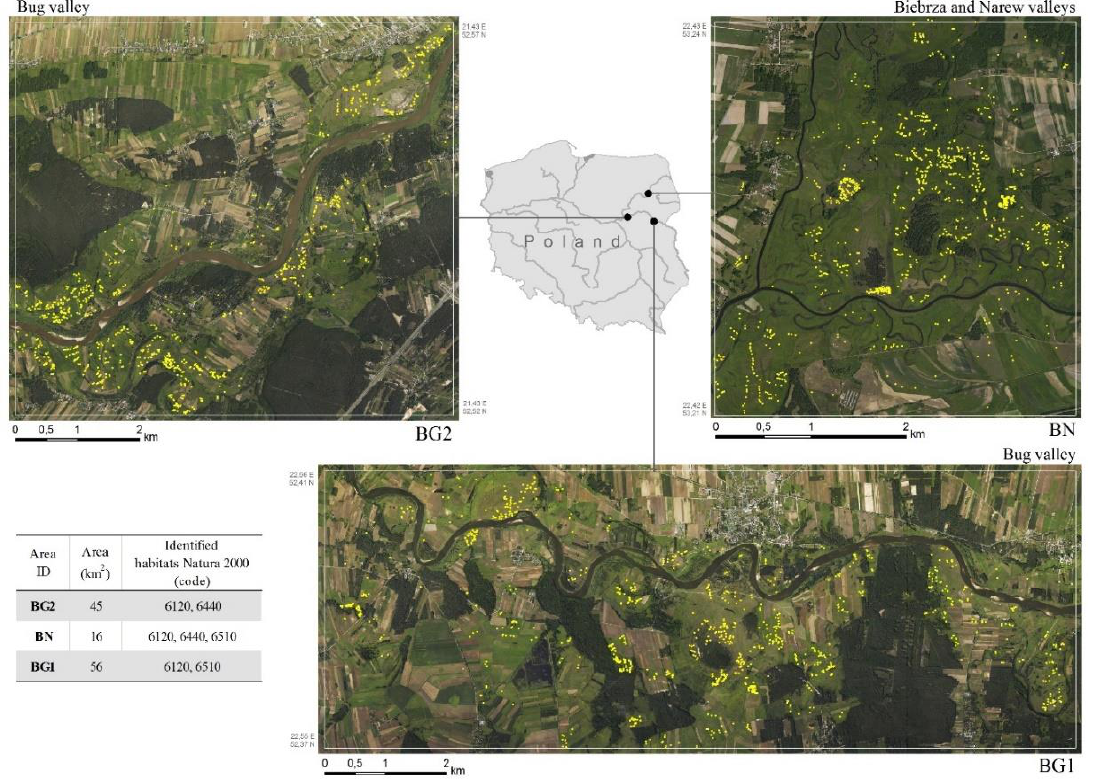
Figure 1. The three study areas selected along different lowland alluvial rivers in Poland ( BG2 , BN , Figure1. Thethreestudyareasselectedalongdi ff erentlowlandalluvialriversinPoland( BG2 , BN , BG1 ). BG1 ). The spatial distribution of reference polygons is also displayed (yellow dots). The spatial distribution of reference polygons is also displayed (yellow